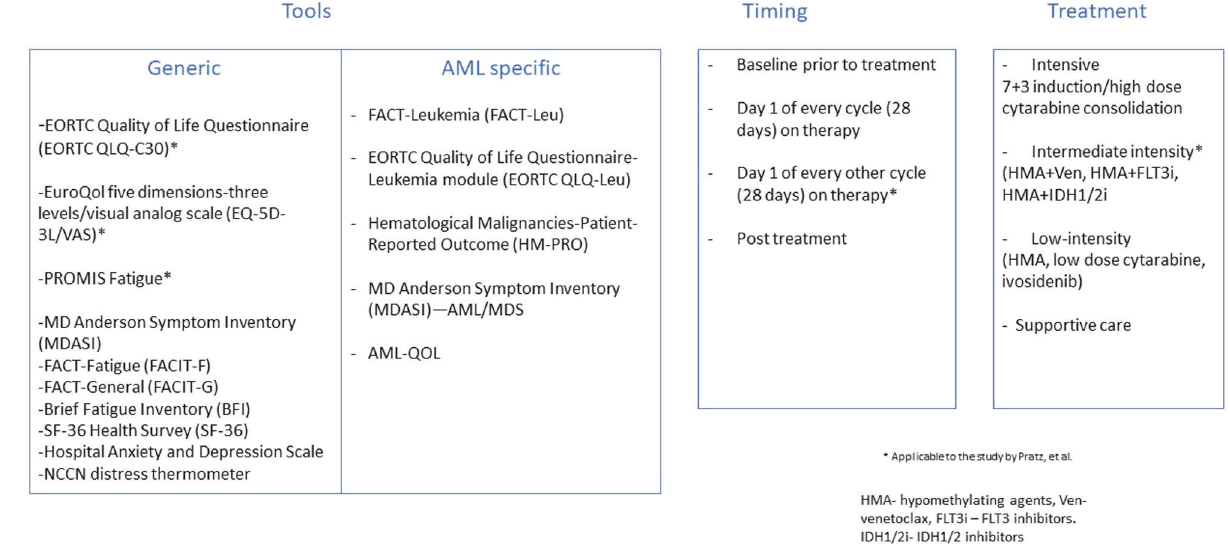
Fig. 1 Considerations for patient-reported outcome measures in acute myeloid leukemia; 3Ts